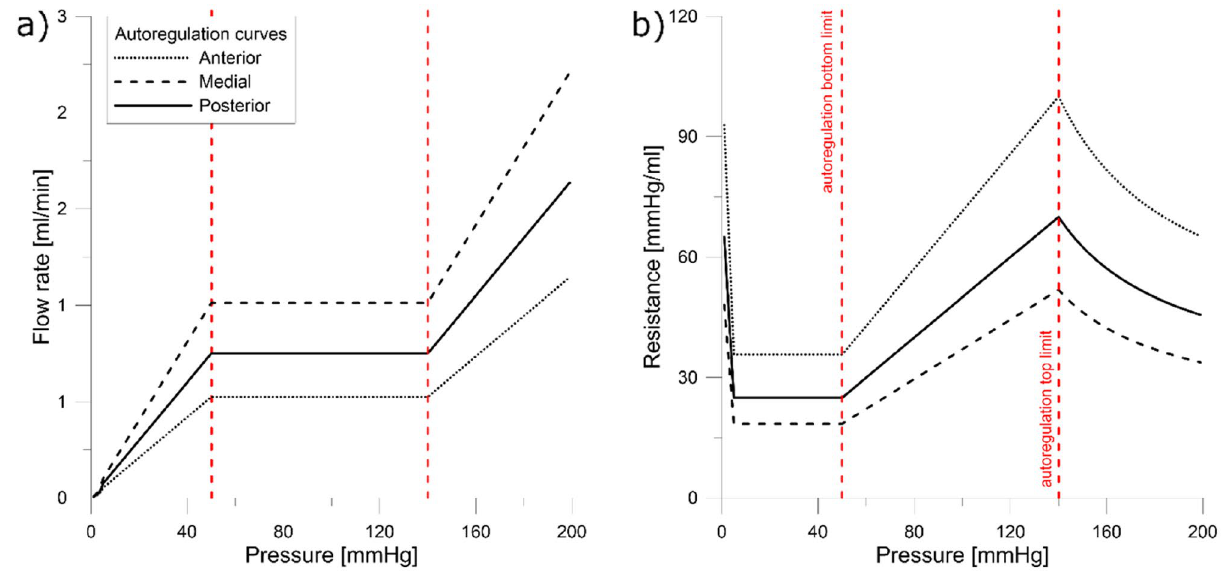
Figure 8. Model of ideal autoregulation of terminal resistances.